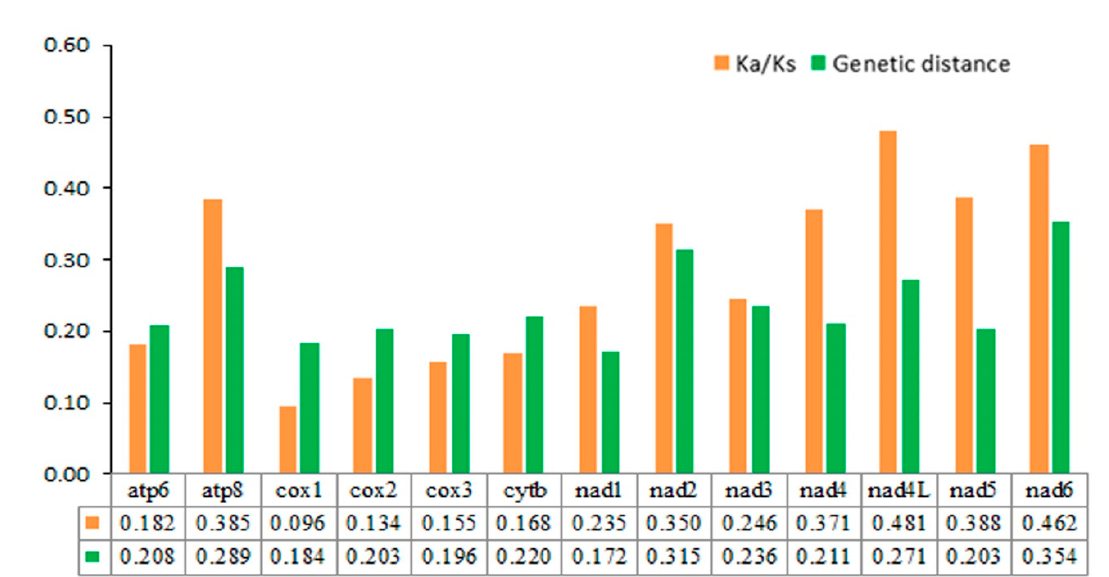
Figure 7. Sliding window analyses of 13 PCGs among seven nitidulid mitogenomes. The red line shows the value of nucleotide diversity (Pi) in a sliding window analysis (a sliding window of 200 bp with the step size of 20 bp); the Pi value of each gene is shown under the gene name.